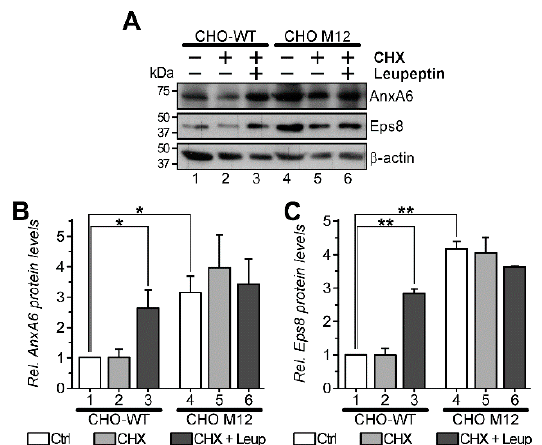
Figure 2. Reduced lysosomal degradation of AnxA6 and Eps8 in NPC1 mutant cells. ( A ) CHO-WT (lane 1–3) and CHO M12 (lane 4–6) cells treated without (control) or with 100 µ g / mL cycloheximide (CHX) alone or together with 10 µ g / mL leupeptin (CHX + Leup) as indicated for 48 h. Cell lysates were prepared and analyzed by Western blotting for AnxA6, Eps8 and β -actin levels as indicated. ( B , C ) The intensity of bands was densitometrically quantified. Data shown represents the mean ± SEM of two independent experiments (* p < 0.05, ** p < 0.01).